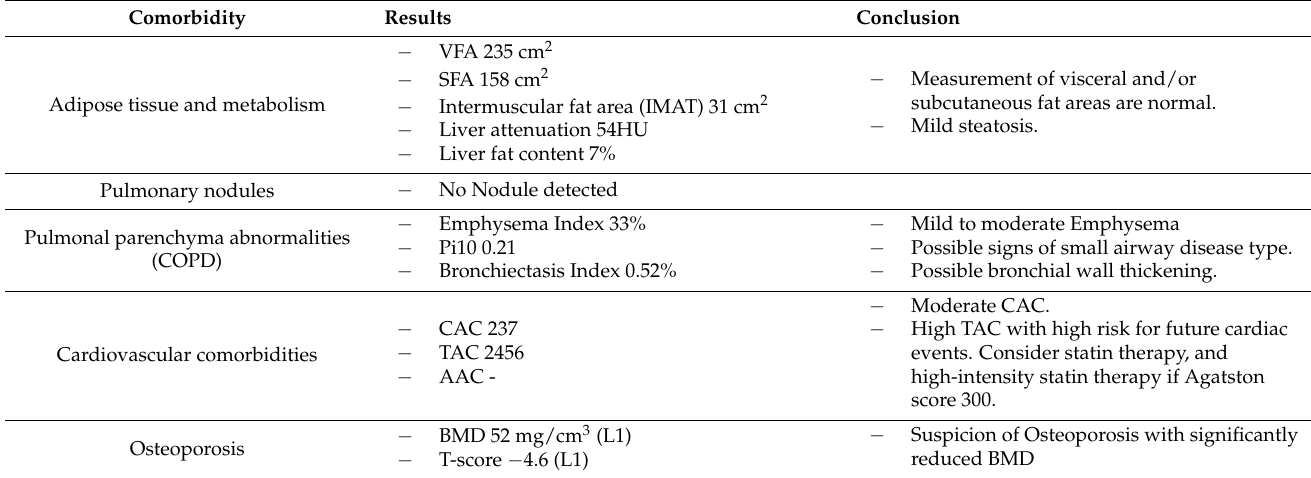
Table 3. Summary of the results of Example No. 2 ‘COPD